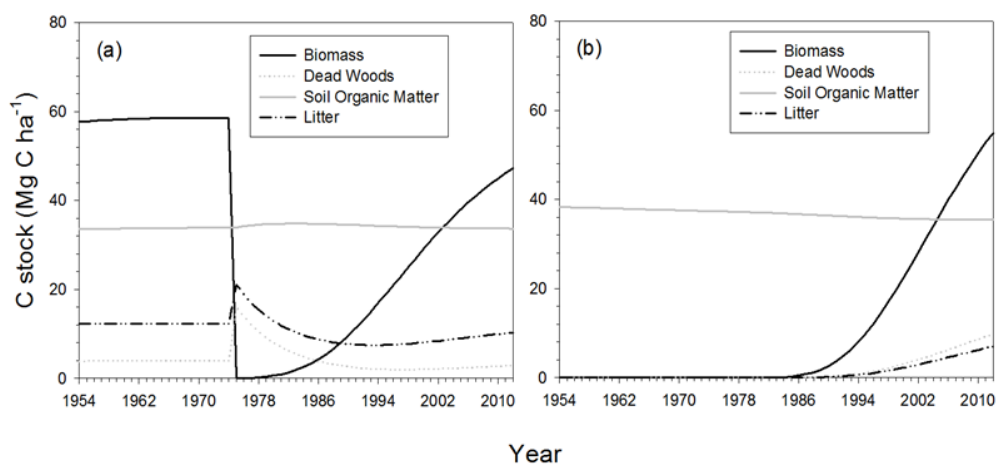
Figure 2. Examples showing the carbon dynamics (biomass, dead woods, soil organic matter, and litter) simulation for each scenario; spin-up scenario (a) and forest recovery scenario (b) . The spin-up scenario simulates carbon dynamics under periodic harvesting. The forest recovery scenario simulates carbon dynamics from deforestation. In this scenario, forest carbon stocks start increasing as the forest stand